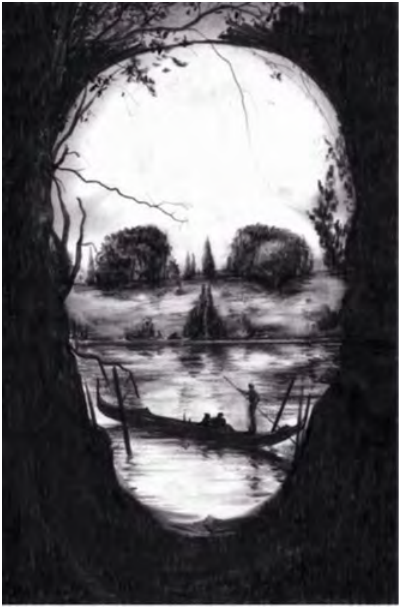
Figure 1 | attributed to Charles Allan Gilbert,